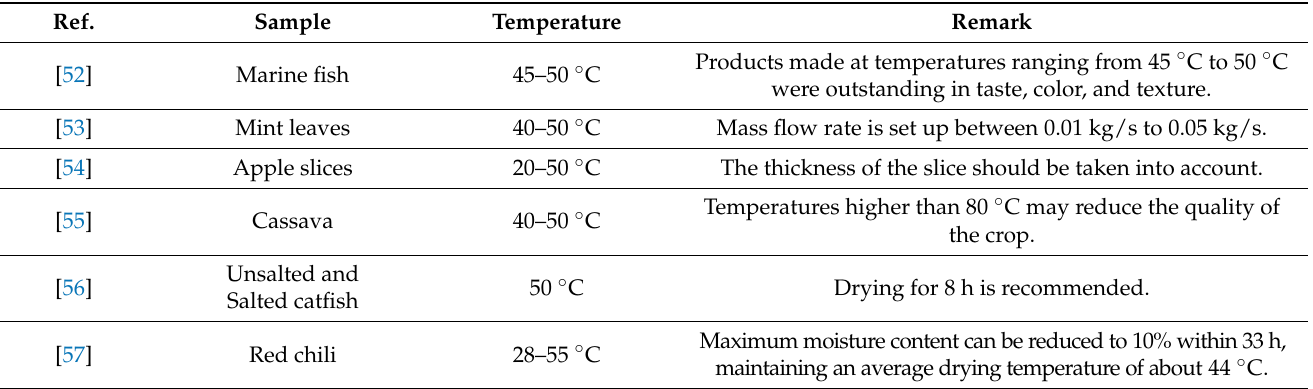
Table 5. Dried products from selected studies.